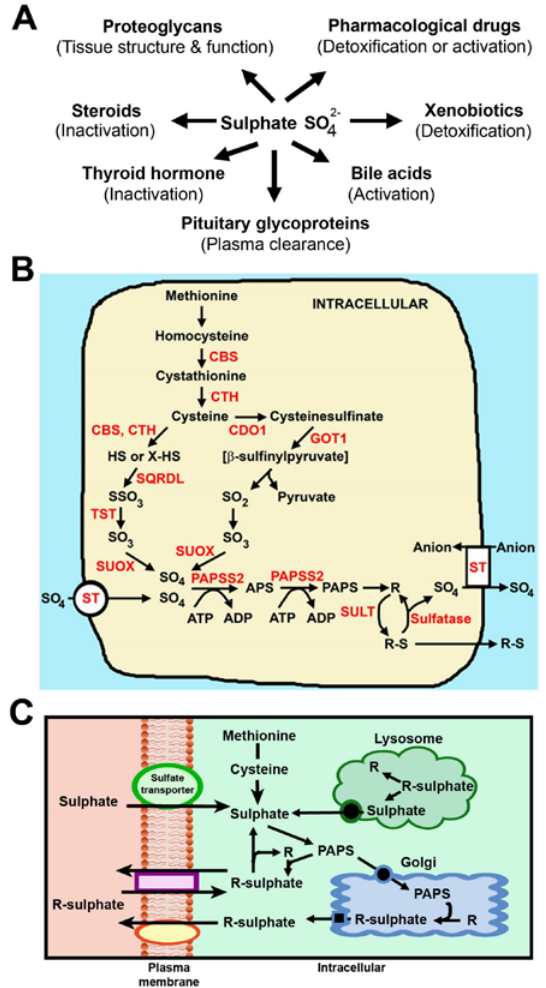
Figure 1. Biological roles of sulphate and pathways of sulphate homeostasis. ( A ) Sulphonation contributes to numerous cellular and metabolic functions in human